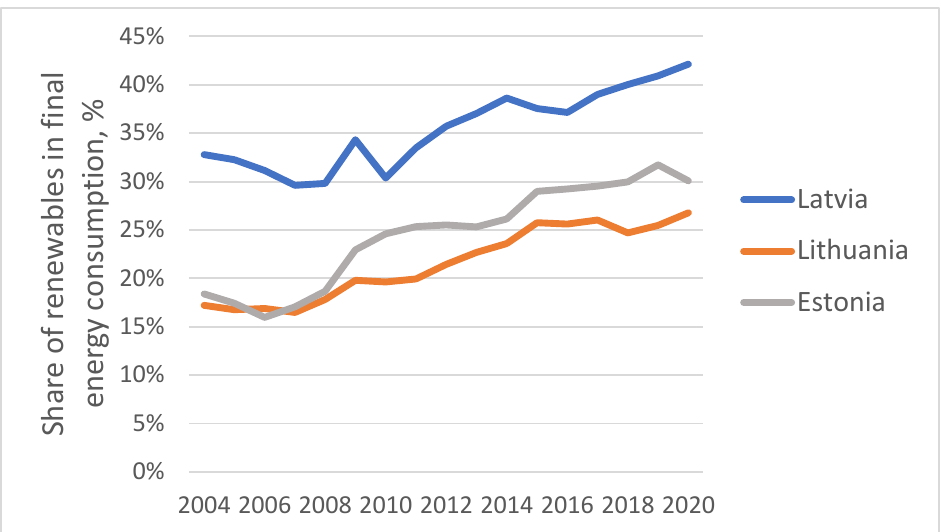
Figure 2. Dynamics of the share of renewables in gross final energy consumption in Baltics. Source: Created by authors. Based on Reference [44].